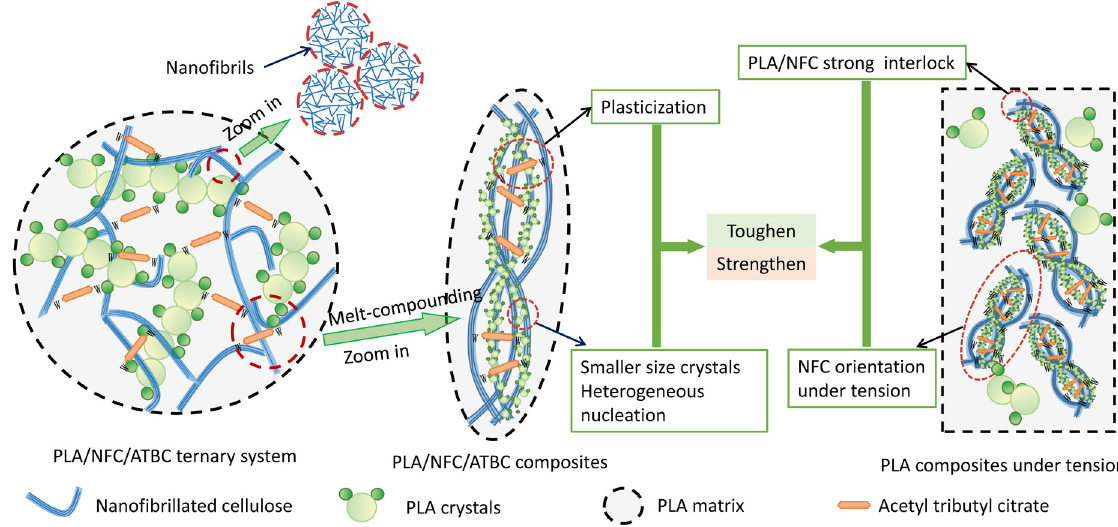
Figure 6: Schematic illustration of the toughening and strengthening mechanism of the